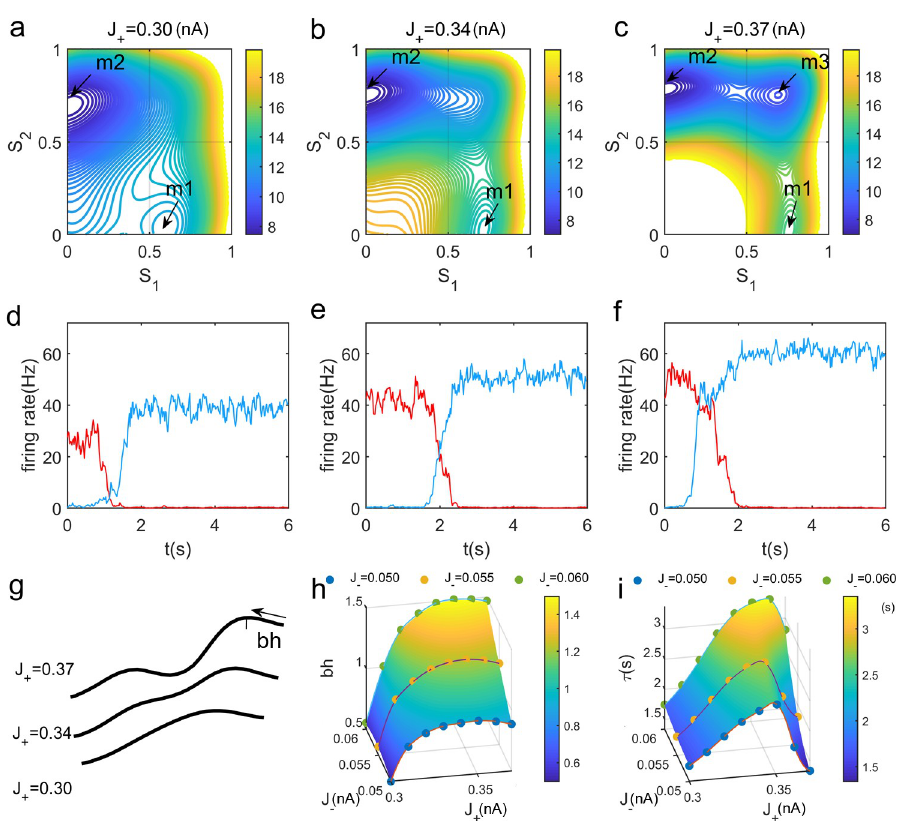
Fig 3. The robustness against distractors during the maintenance phase. (a-c) The potential landscapes for different self-excitations J + = 0.30, 0.34, 0.37 nA in the presence of a distractor stimulus. Here J − = 0.05 nA in (a-g). The attractor r for the resting-state cannot be held and the distractor-related memory attractor m 2 becomes dominated. There is also a new intermediate state m 3 between the two memory states for further increasing J + in Fig 3(c). (d-f)Neural activities of the single trails correspond to the potential landscapes for increasing J + in the top panels. The blue and red lines represent the activities of population 1 and population 2, respectively. The system can be driven away from the target- related WM attractor by the intervening distractor. (g)The schematic diagram of the barrier heights on the corresponding potential landscapes for increasing J + . (h-i)Robustness of WM against distractors as a function of self- excitations J + and mutual inhibition J − through quantifying the corresponding barrier height and the mean first passage time(MFPT).